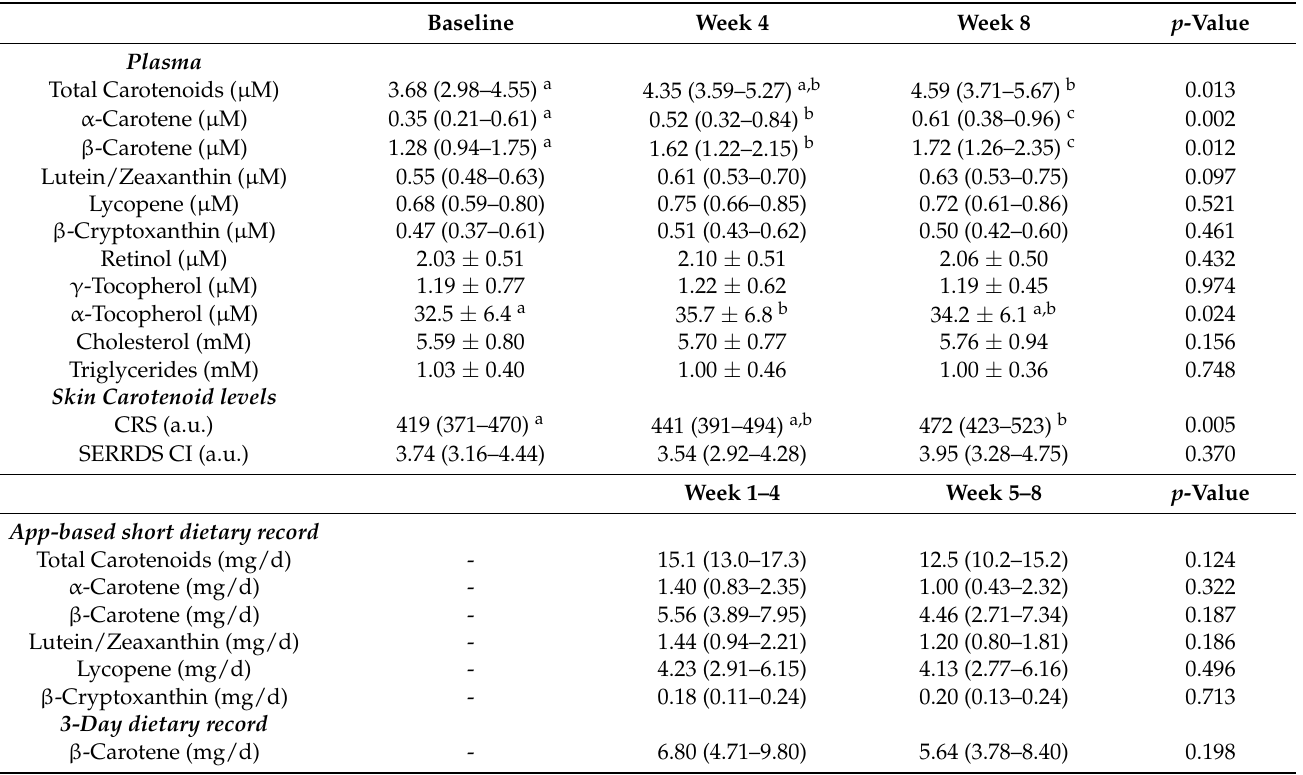
Table 2. Plasma concentrations, skin levels and dietary intake data of fat-soluble micronutrients over the study